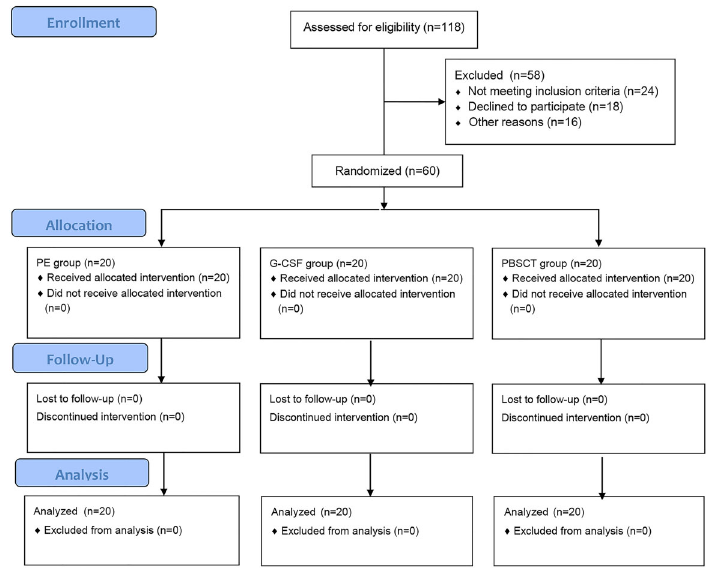
Figure 2. Study fl ow diagram. PE, plasma exchange. G-CSF, granulocyte colony-stimulating factor. PBSCT, peripheral blood stem cell